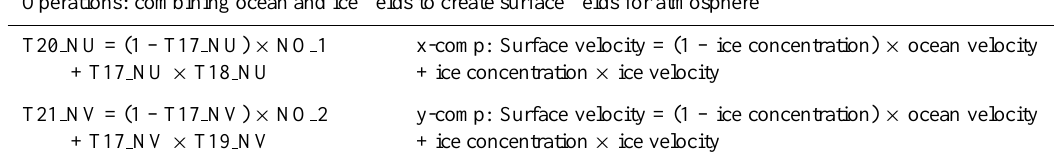
Table 2c. Details of combining the ocean and ice fields to create surface fields for the atmosphere in Fig. 5. These manipulations are in the NEMO subroutine CICE SBC HADGAM . Operations: combining ocean and ice fields to create surface fields for atmosphere